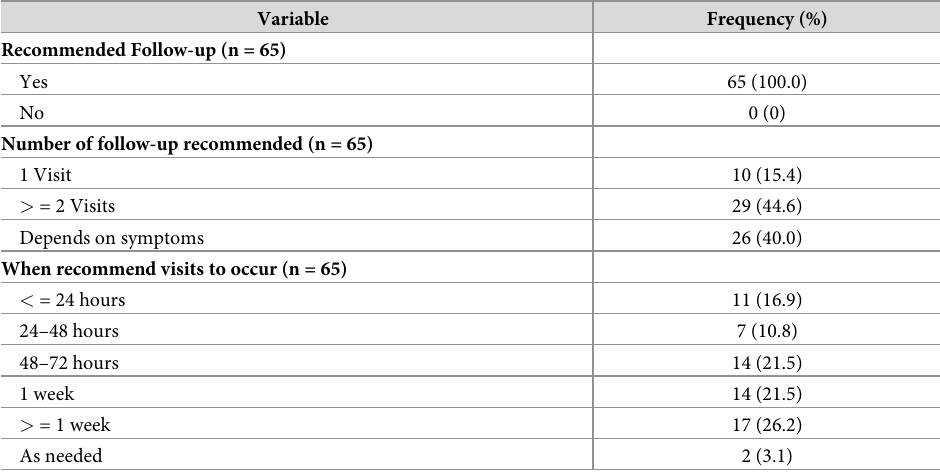
Table 5. Patient follow-up recommendation–count and